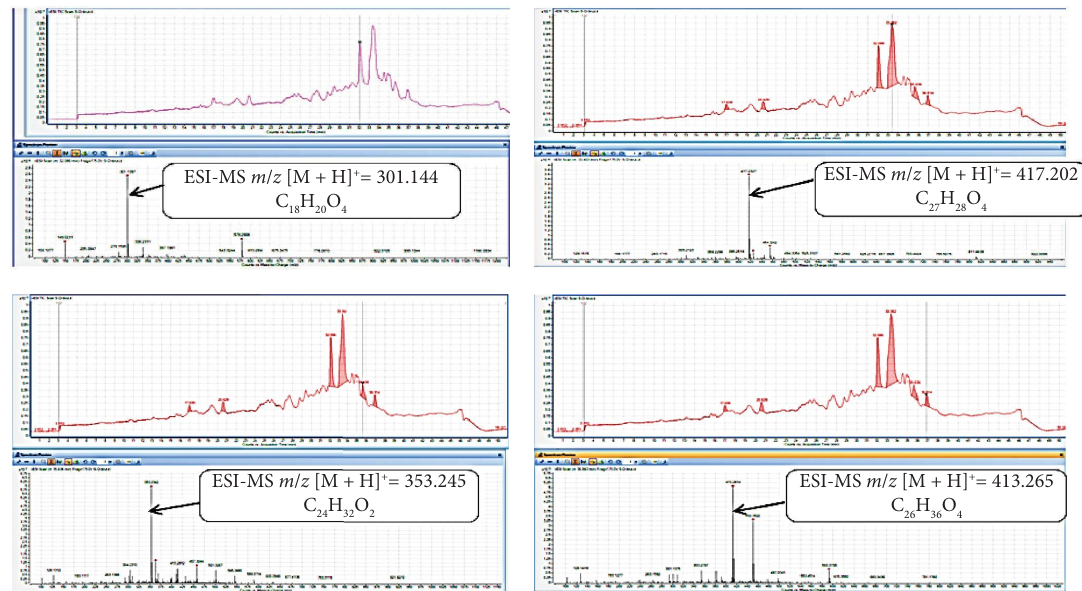
Figure 5: Chromatograms and mass spectra of the ethanol extract of Antrocaryon klaineanum